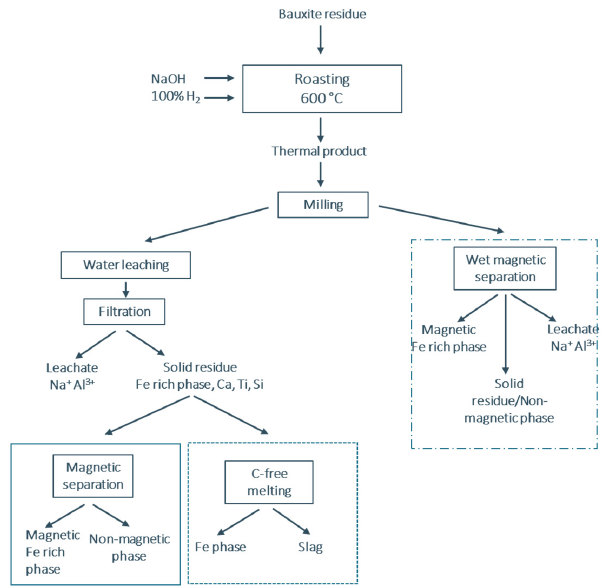
Figure 1. Three H 2 -based processes for Al and Fe recovery from bauxite residue. Each parallelogram shows a different process.